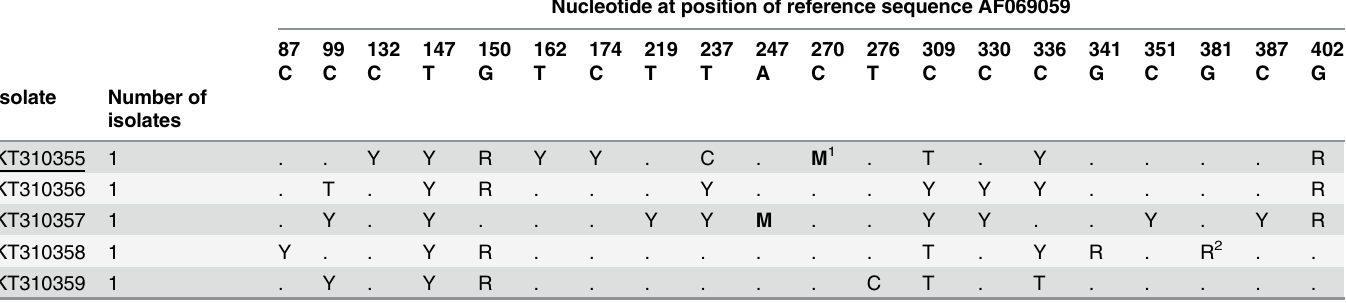
Table 4. Diversity and frequency of single-nucleotide polymorphisms displayed by Giardia duodenalis sub-assemblage BIII isolates at the gluta- mate dehydrogenase locus (partial sequence between positions 61 to 450) identified in the present study. Novel genotypes were shown underlined. Point mutations inducing amino acid substitutions were highlighted as superscript numbers indicating the amino acid change. Transversion mutations were highlighted in